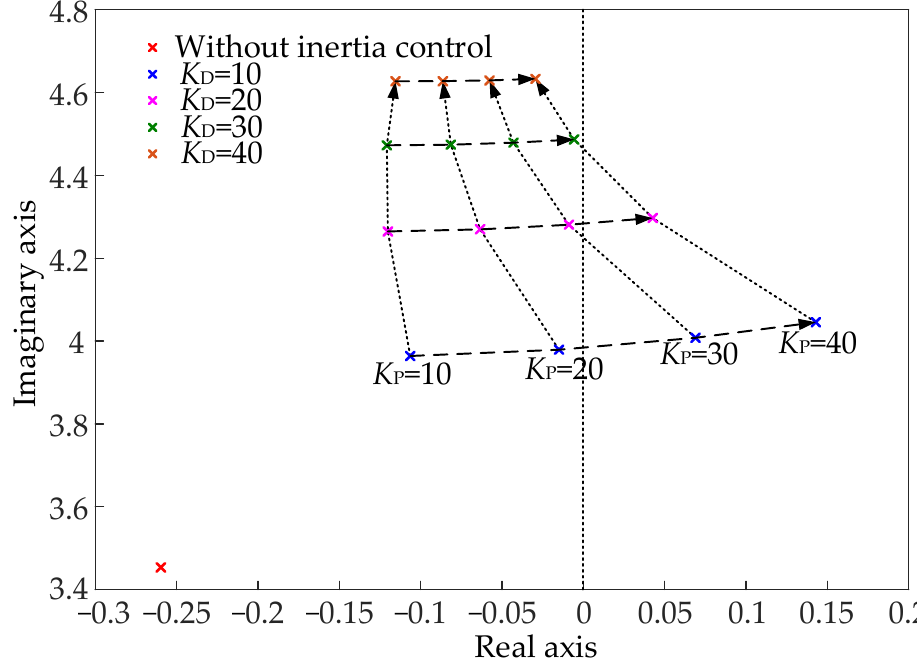
Figure 5. Eigenvalue analysis results of the inter-area oscillation mode under different control gains. According to Figure 5, when K P is small, with the increase of K D , the eigenvalue of the inter-area oscillation mode first moves left and then right, and the corresponding damping ratio first increases and then decreases; when K P is large, with the increase of K D ,